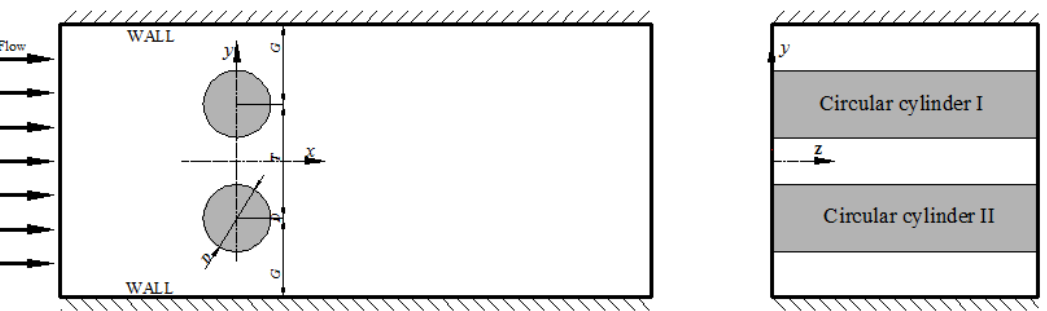
Figure 1. Schematics of flow around two side-by-side cylinders.